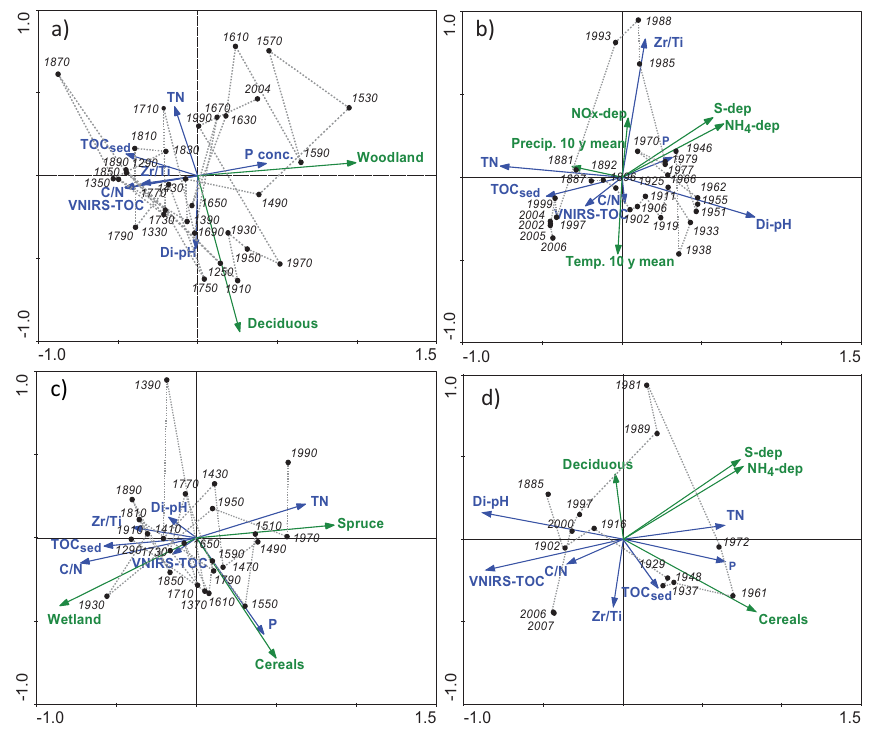
Figure 4. Scores for samples (black circles), palaeolimnological parameters (blue arrows) and driving forces (green arrows) on the first and second axes of the redundancy analyses for (a) Åbodasjön AD1200–present, (b) Åbodasjön AD1880–present, (c) Lindhultsgöl AD1200– present and (d) Lindhultsgöl AD1880–present. Sample ages represent the midpoint of each 20-year time